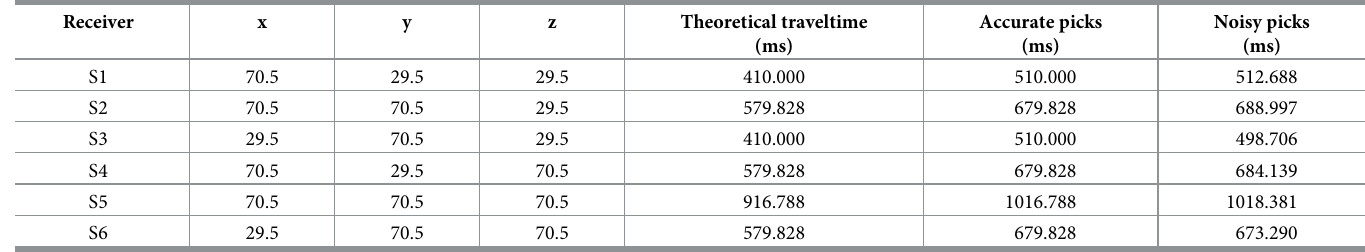
Fig 6. It can be seen that the influence of m is very limited, but it locates the event precisely when m is 2. Thus, the optimized norm ( m = 2) is used in the following synthetic tests and field applications. Errors between the actual arrival and the picked arrival always exist. Therefore, for compar- ison, noisy picks are calculated by adding random perturbations to the accurate arrival times, as listed in Table 1. We then calculate the event locations for the two schemes using the Table 1. Input parameters for the event location in example